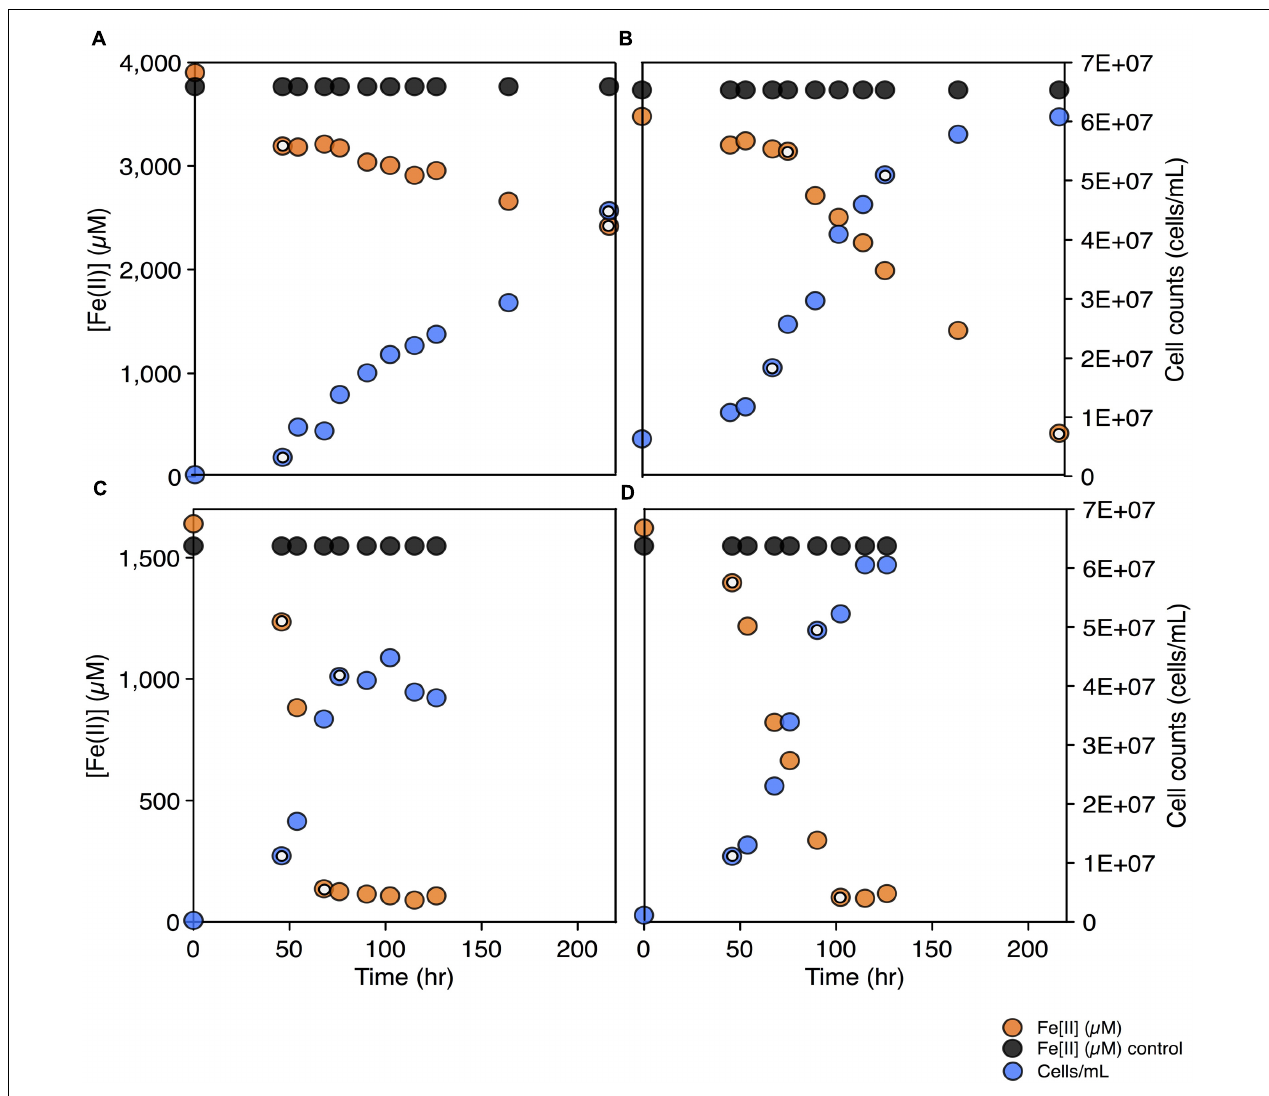
FIGURE 2 | Fe(II) concentrations and cell counts over time for both C. phaeoferrooxidans (A,C) and C. ferrooxidans (B,D) under two sets of media: no bioavailable nitrogen – N 2 as sole nitrogen source (A,B) and ammonium rich (C,D) . Data points used to calculate growth rates and Fe(II) oxidation rates are highlighted in each